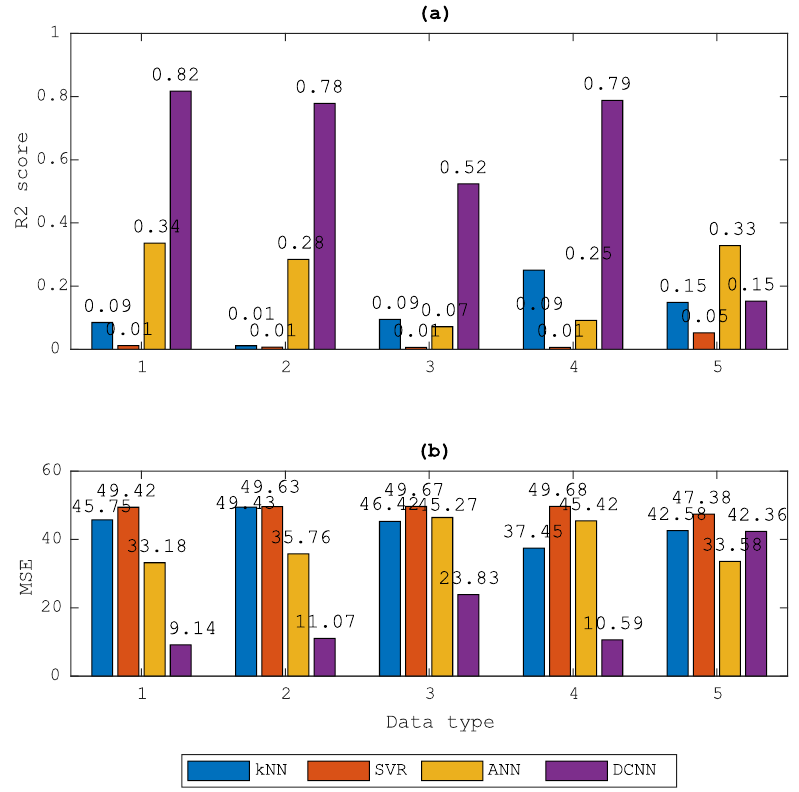
Figure 17. Comparison of accuracy in terms of R2 (a) and MSE (b) score from four different regression models: kNN, SVR, ANN and DCNN.